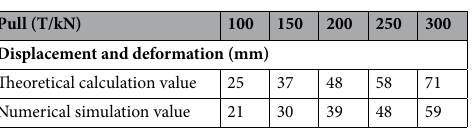
Table 3. Comparison between theoretical calculation and numerical